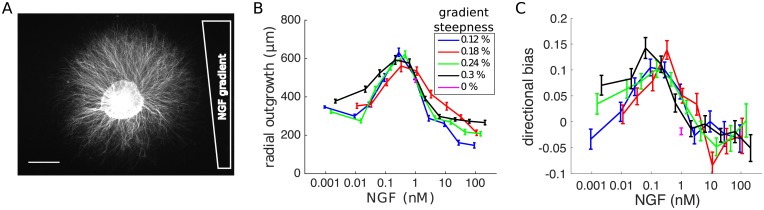
Analysis of NGF gradient data set.(A) Example image from the data set of ref. [18], which documents the total growth of DRG explants after 48 h in shallow NGF gradients. Experimental conditions were varied over gradient steepnesses 0 − 0.3% concentration change per 10 μm, and background concentrations of ≈ 0.001 − 100 nM (scale bar 500 μm). (B) Average radial outgrowth, quantified by Fourier coefficient a0, has a biphasic dependence on background NGF concentration, and is largely independent of gradient steepness. (C) Directional bias up the gradient, quantified by normalised coefficient b1/a0, was observed over background concentrations 0.01 − 1 nM, implying a high sensitivity to NGF.